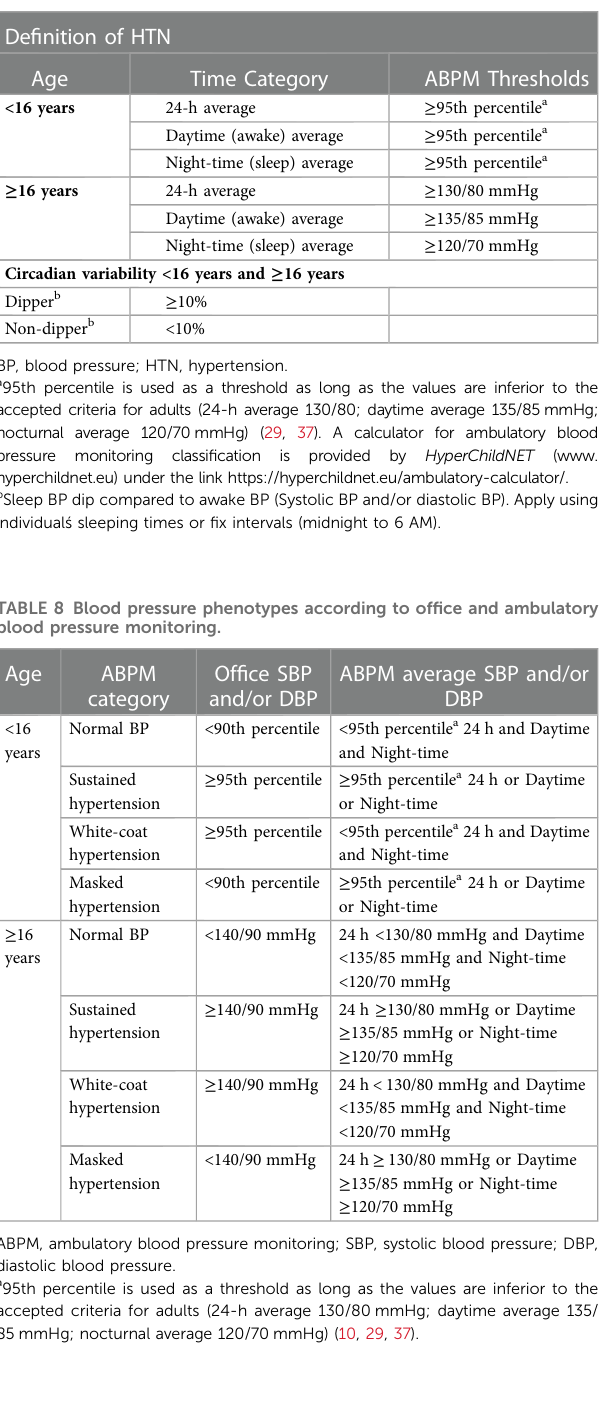
TABLE 7 Interpretation of 24-h ambulatory blood pressure monitoring. TABLE 9 Advantages and limitations of home blood